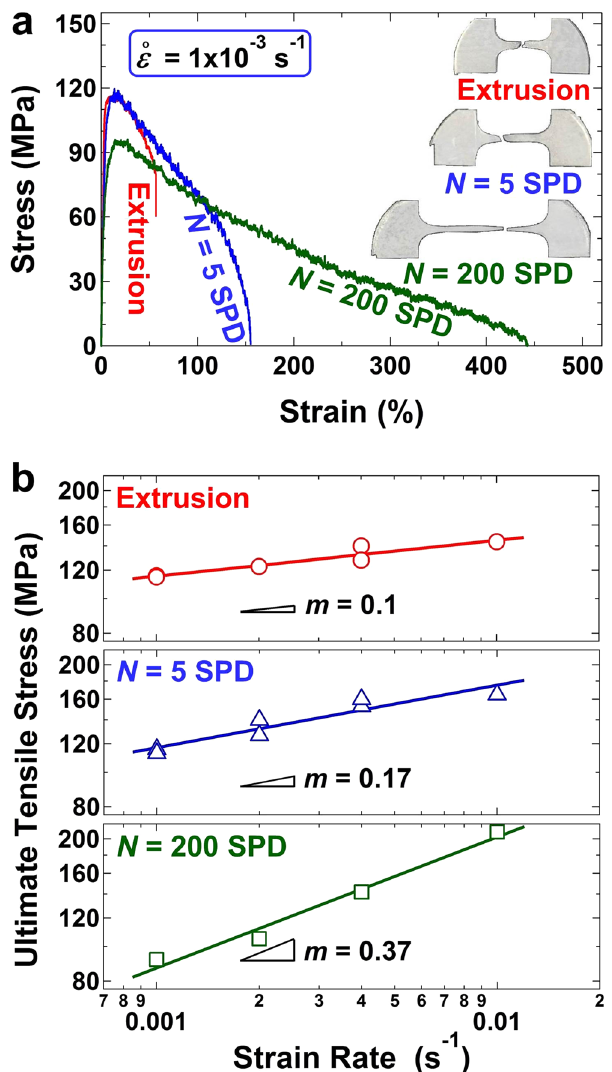
Figure 3. Tensile plasticity and strain-rate sensitivity enhances after SPD processing. Results of tensile tests performed at 300 K for the samples processed by extrusion and SPD for N = 5 and 200 cycles. ( a ) Stress-strain curves measured at a strain rate of 1 × 10 − 3 s − 1 . Inset: appearance of tensile specimens after pulling to failure. ( b ) Ultimate tensile stress as a function of strain rate; the slopes represent the strain-rate sensitivity, m . The sample after 200 SPD cycles exhibits room-temperature superplasticity with m =